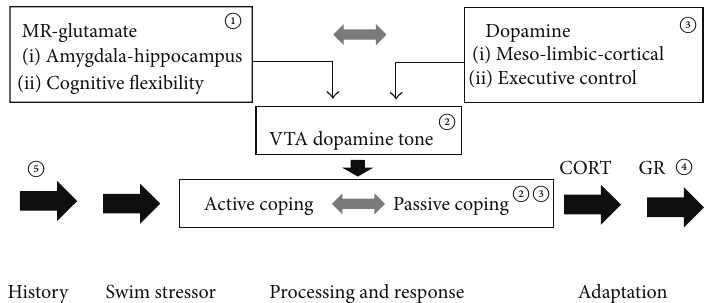
Figure 5: Hypothesis: processing of the forced swim stressor. A The stressor is perceived and appraised and the appropriate coping style is selected depending on flexibility of amygdala-hippocampus-striatal connectivity, which is controlled by CORT via limbic MR. B This action of CORT mediated by MR modulates the hippocampal excitatory outflow through enhanced glutamate transmission driving the spontaneousactivityoftheVTA-A9neuronsandactivecoping. C Whentimeelapsesenergyisallocatedtomoreexecutivefunctionsgoverned by mesocortical and prefrontal circuitry attenuating mesoaccumbens dopamine activity causing a switch from active to passive coping with the inescapable forced swim stressor. D The coping response is stored in memory for future use by a mechanism activated by stress-induced levels of CORT acting through the GR in the hippocampal dentate gyrus. E The information processing during the forced swim is affected by stress history as can be deducted from altered genomic expression in the hippocampus. This hypothesis is based on the following